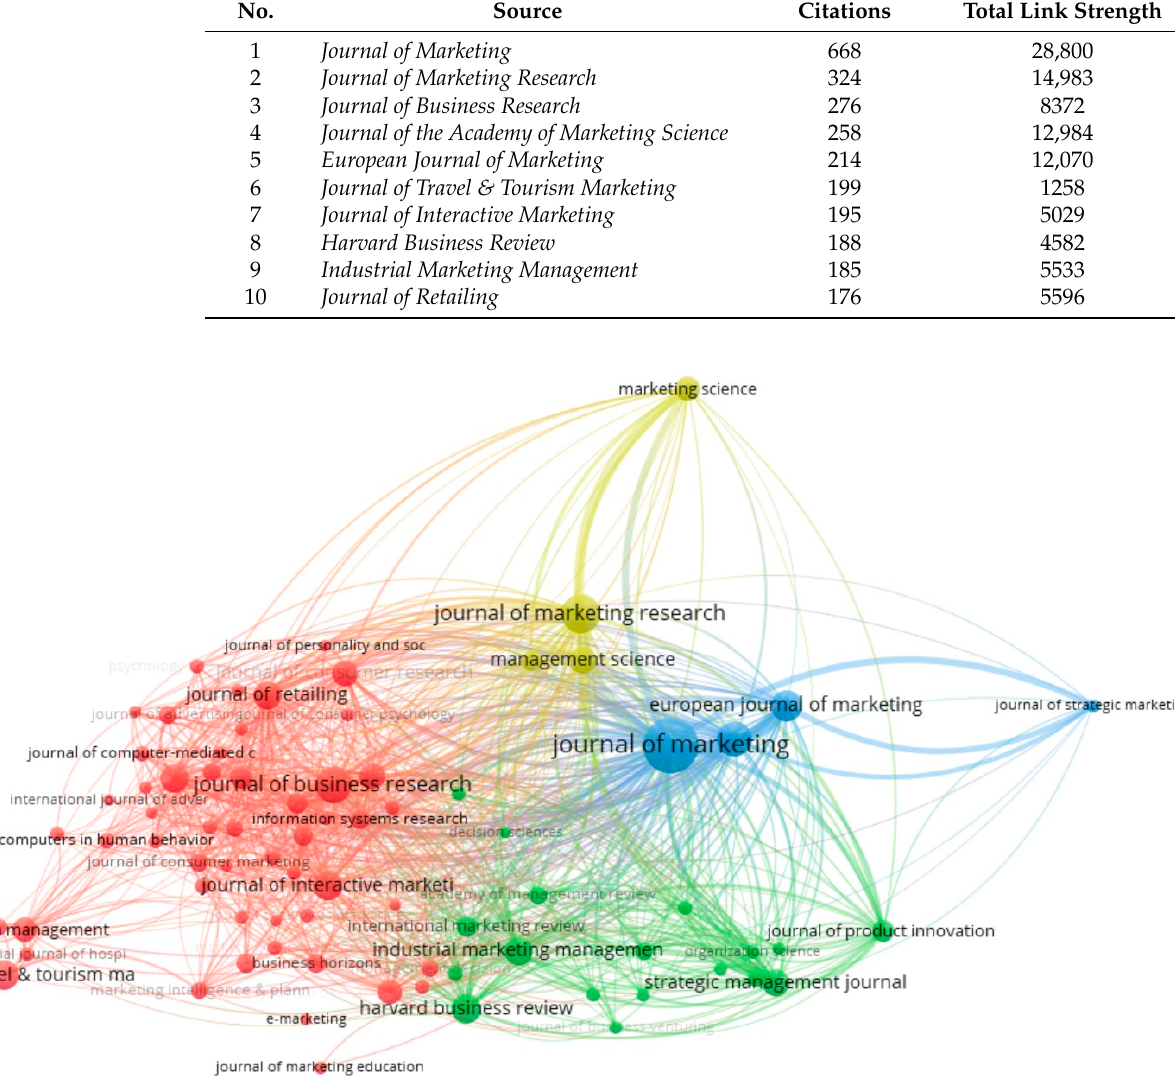
Table 5. Co-citation of the top ten journals.